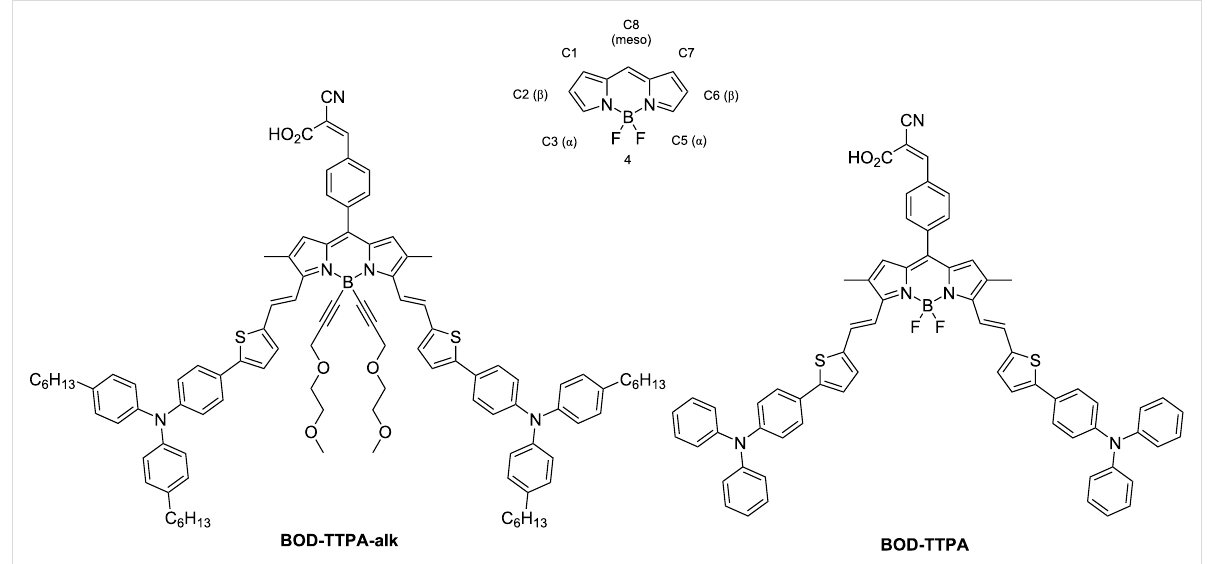
Figure 1: Molecular structures of the two target compounds BOD-TTPA-alk and BOD-TTPA, and the chemical structure of a BODIPY core displaying its positions numbering.